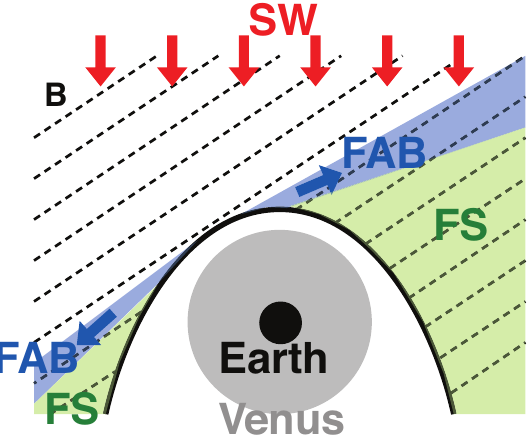
Fig. 1. Schematic illustration of the foreshock (FS) location. Field- aligned ions (FAB) are often observed at the upstream boundary of the foreshock region. Relative sizes of the planets compared to the bow shock are also